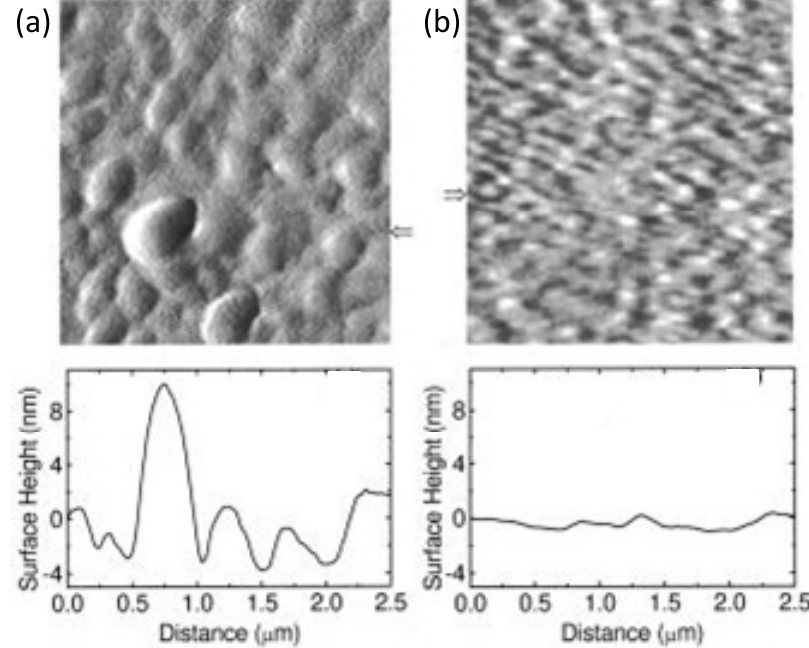
Figure 12. AFM surface morphology of MDMO-PPV/PCBM (1:4 wt%) BHJ thin-film spin coated with different solvents: ( a ) toluene; ( b ) chlorobenzene. The cross sections below the images are taken horizontally corresponding with the arrows. (Reprinted with permission from Reference [121]. Copyright (2001) by American Institute of